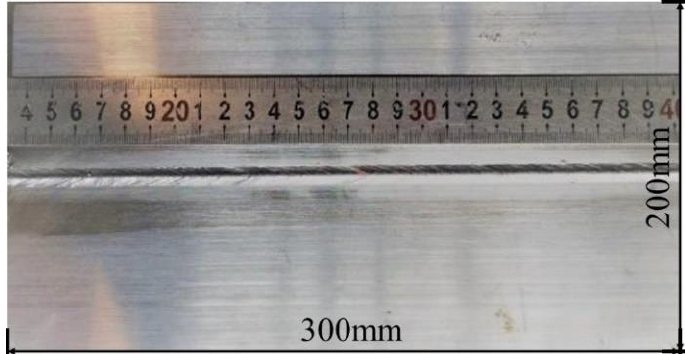
Figure 11. Macro morphology of weld with penetration of 23 mm.